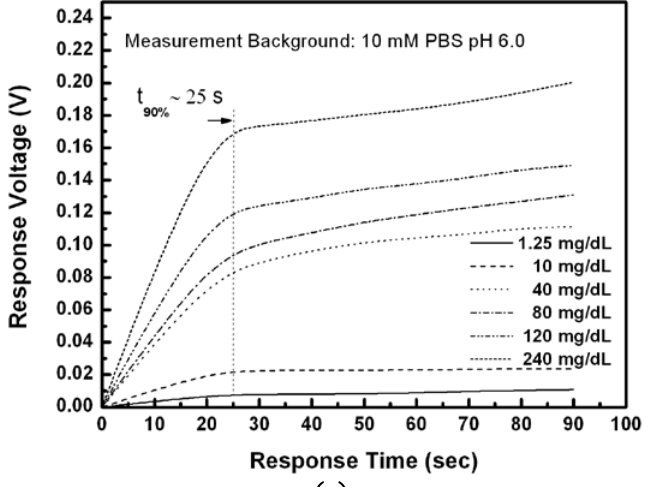
Figure 7. (a) Urea response of the GRE/EnFET (b) Storage and repeatability performances of the GRE/EnFET dL in axis